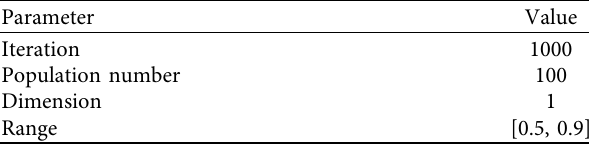
Table 3: Simulation parameters for power allocation.